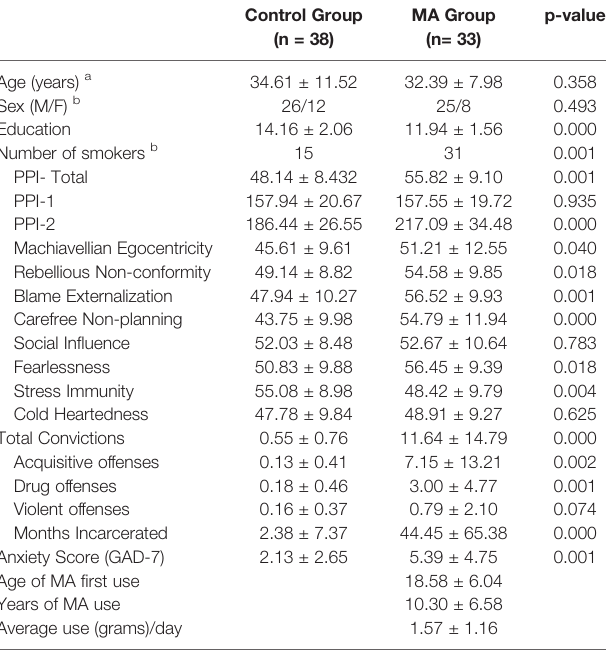
TABLE 2 | Participant